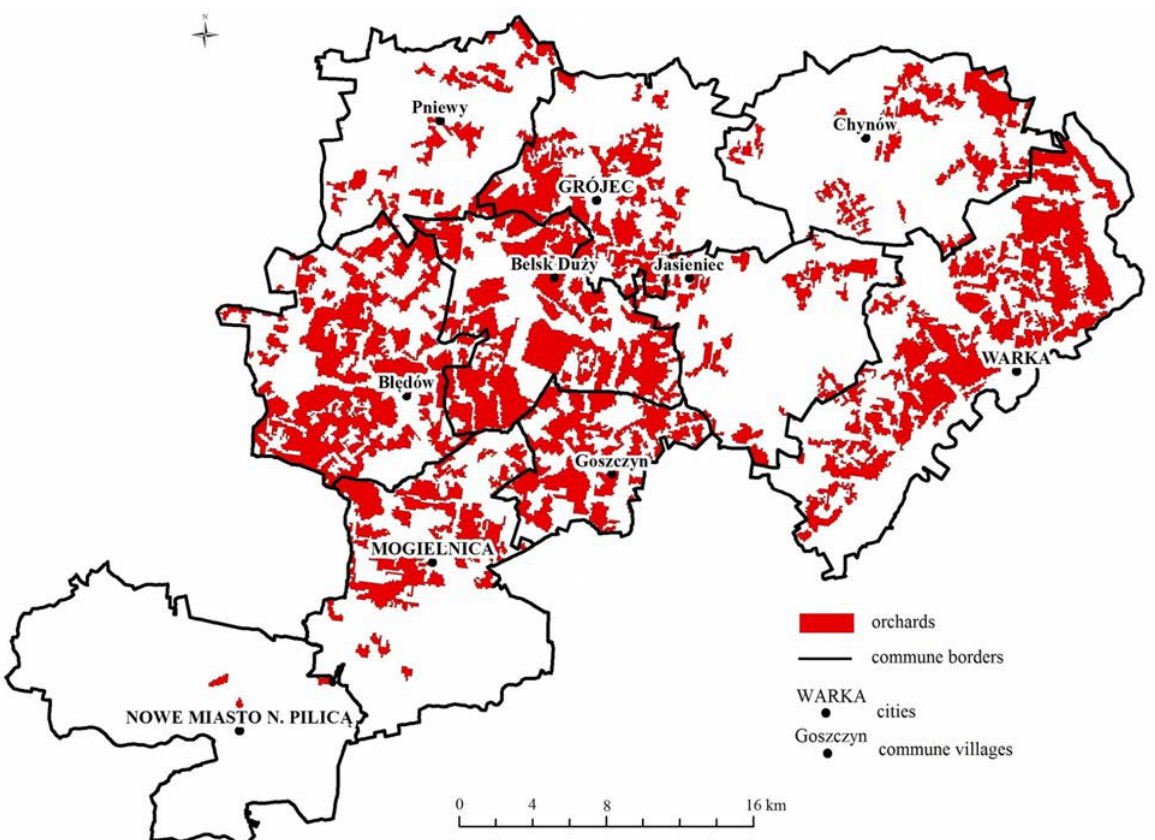
Fig. 6. Distribution of orchards in Grójec poviat in 1990. Source: own study based on Corine Land Cover